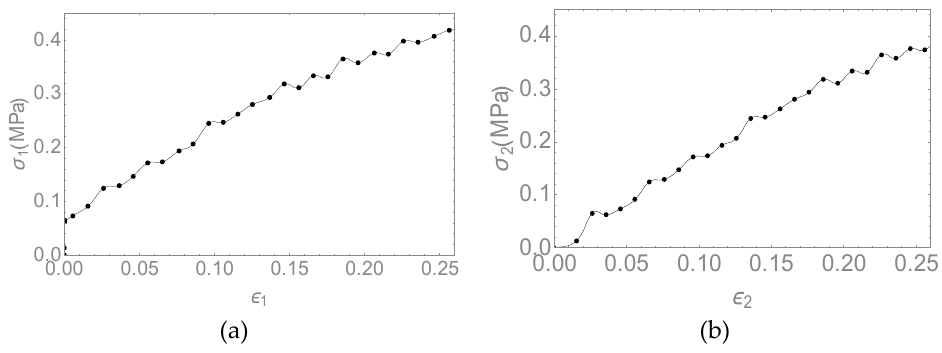
Figure 7. Stress strain curves of AFA300: ( a ) Direction x 1 , and ( b ) direction x 2.